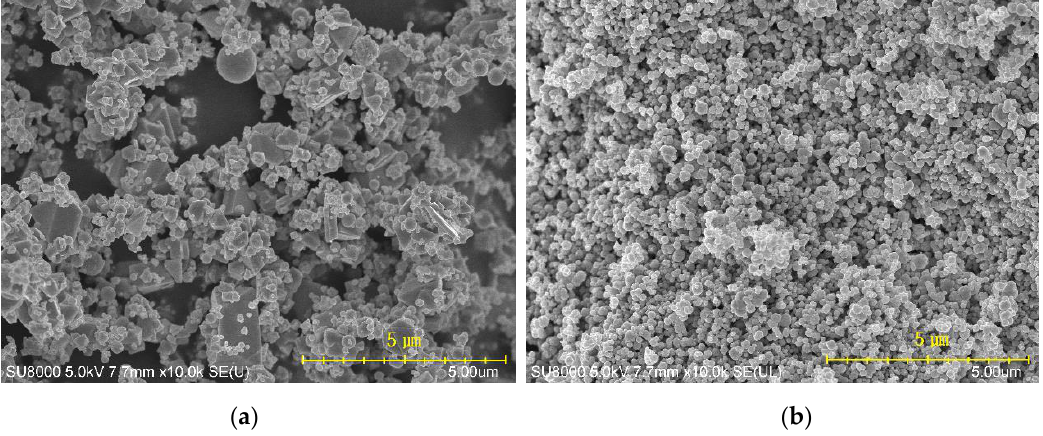
Figure 8. SEM images of the powder particles of ( a ) ATO and ( b ) ZHS.